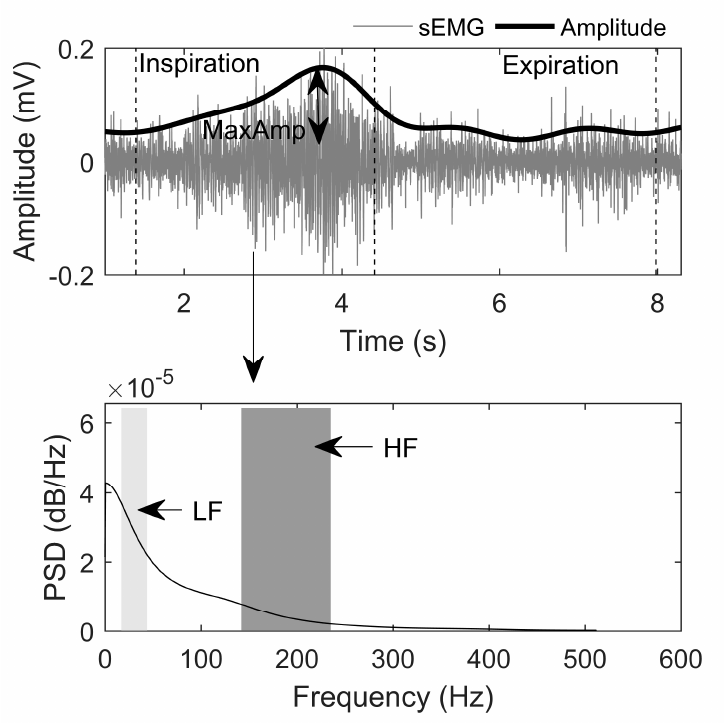
Figure 2. sEMG indexes in time and frequency domain during the inspiratory phase. MaxAmp, the maximum amplitude of the sEMG signal; HF and LF, the high and low frequency ranges for calculating RHL. Table 1. sEMG indexes in time and frequency domains for each one of the recorded muscles, diaphragm (Dia), intercostal (Int) and sternocleidomastoid (Strn). Index Time Domain Index Frequency Domain MaxAmp j